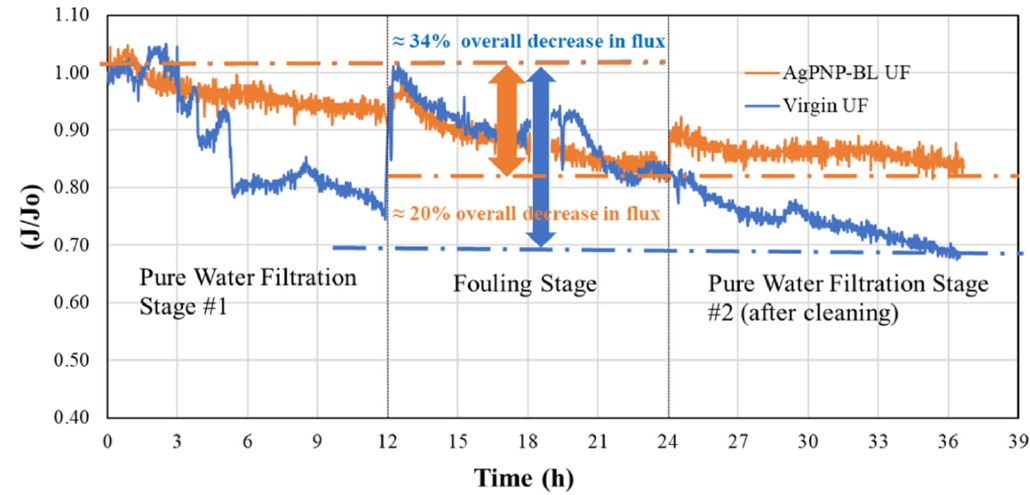
Figure 10. Normalized flux as a function of pressure during different stages of the fouling test.